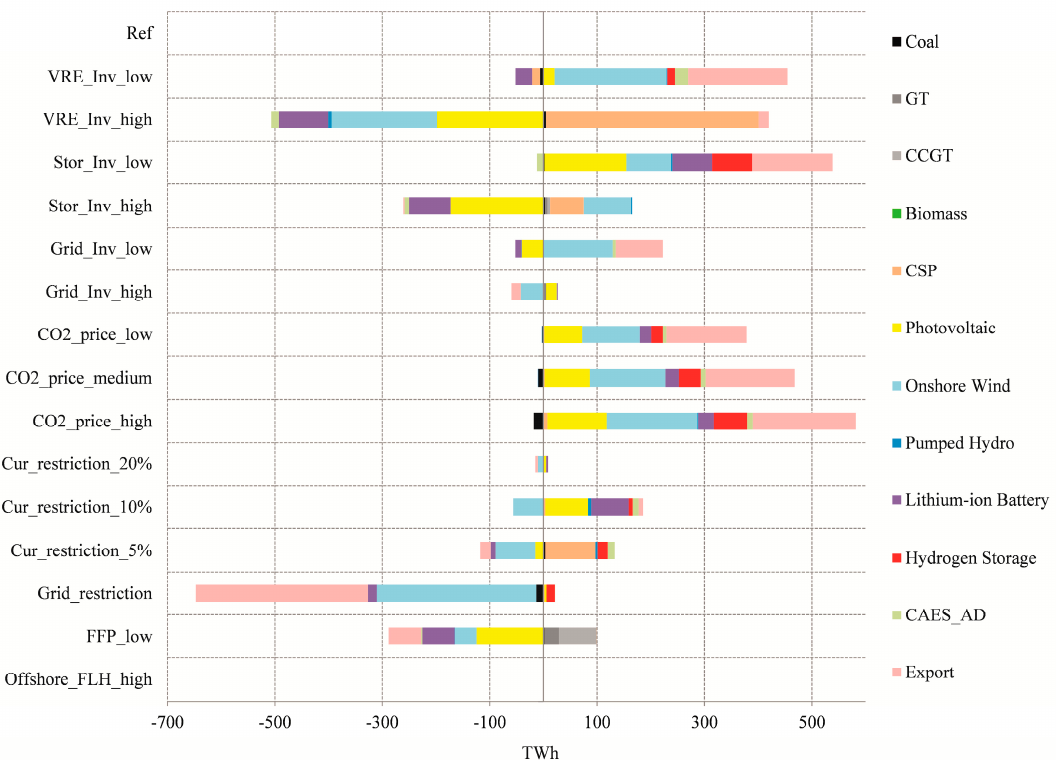
Figure 17. Sensitivity analysis on total installed capacities in 2050 in Inner Mongolia shown as deviations from the reference scenario.